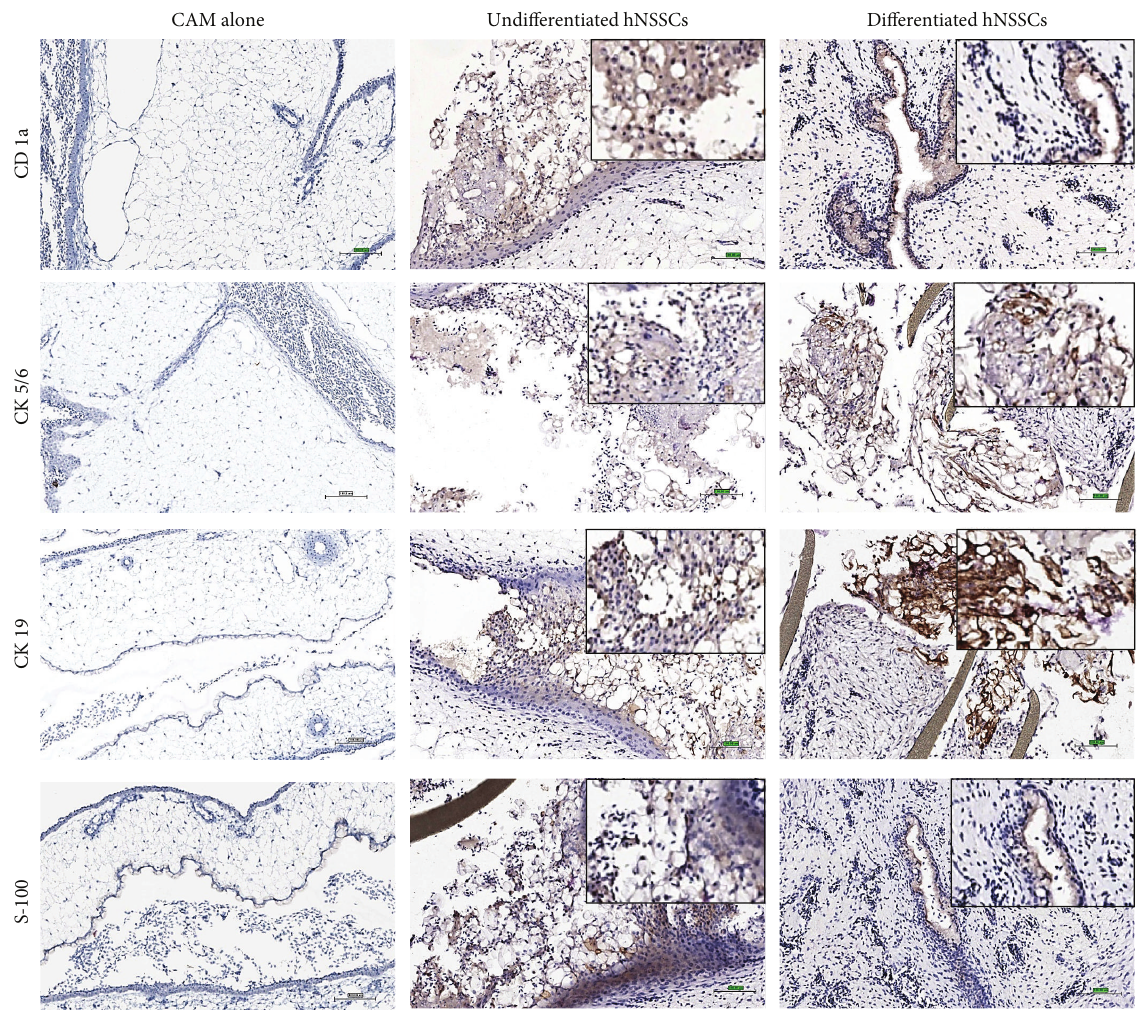
Figure 5: Immunohistochemical staining of CAM alone and CAM grafted hNSSCs for ectoderm-related markers. CAMs were grown as in Figure 4 and subsequently were processed for IHC. Brown colour indicates the positive area of respective skin lineage associated proteins, CD1a, CK 5/6, CK19, and S-100. CK: Cytokeratin (Bar = 100 𝜇